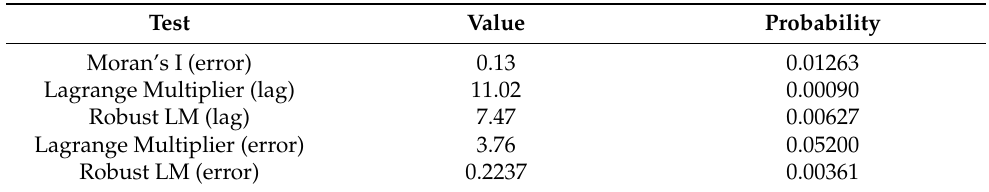
Table 4. Detection of spatial autocorrelation.